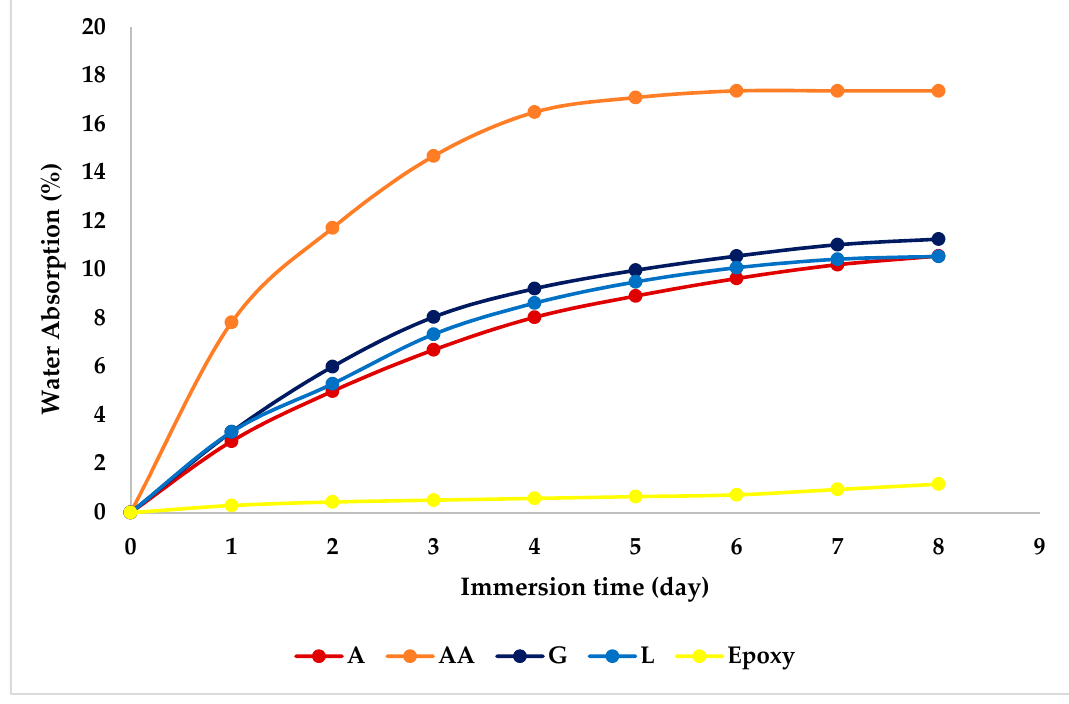
Figure 6. Water absorption tendencies of DPF/epoxy composites.